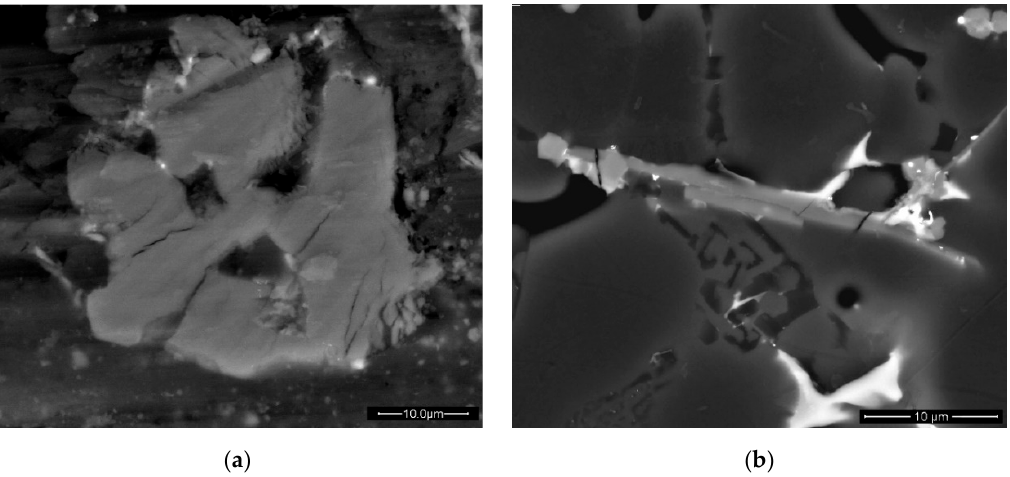
Figure 11. Micrographs of fractured ( a ) α -Al 15 (Fe,Mn,Cr) 3 Si 2 particle and ( b ) β -Al 5 FeSi platelet after wear testing.